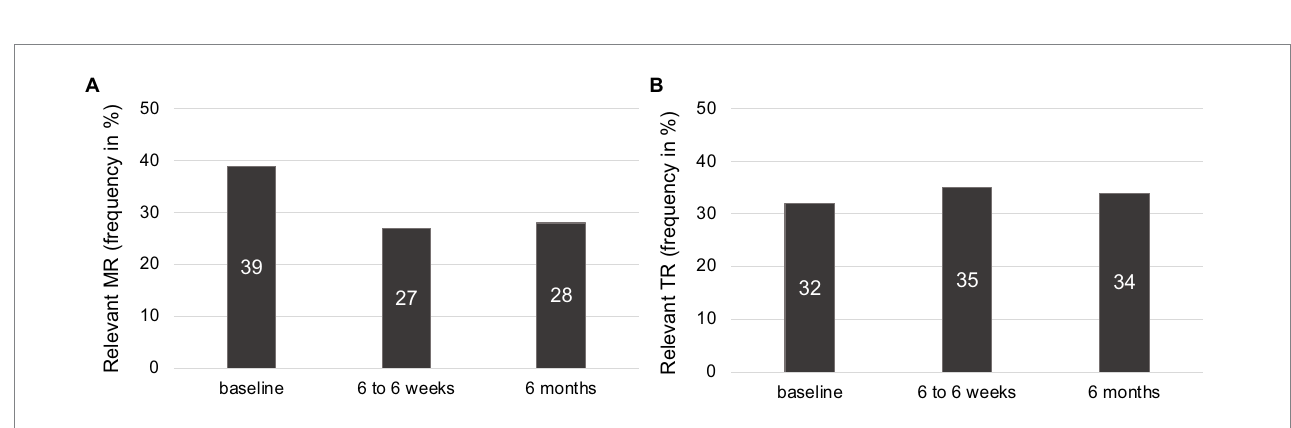
FIGURE 2 Frequency of relevant MR ( A ) and TR ( B ) at baseline, the 6- to 8-week, and the 6-month